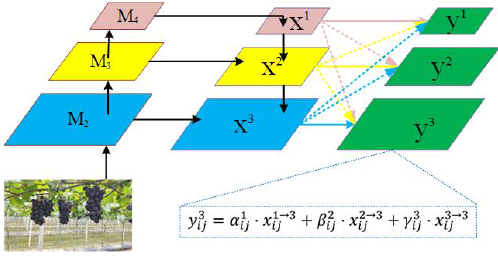
Figure 10. ASFF structure diagram.